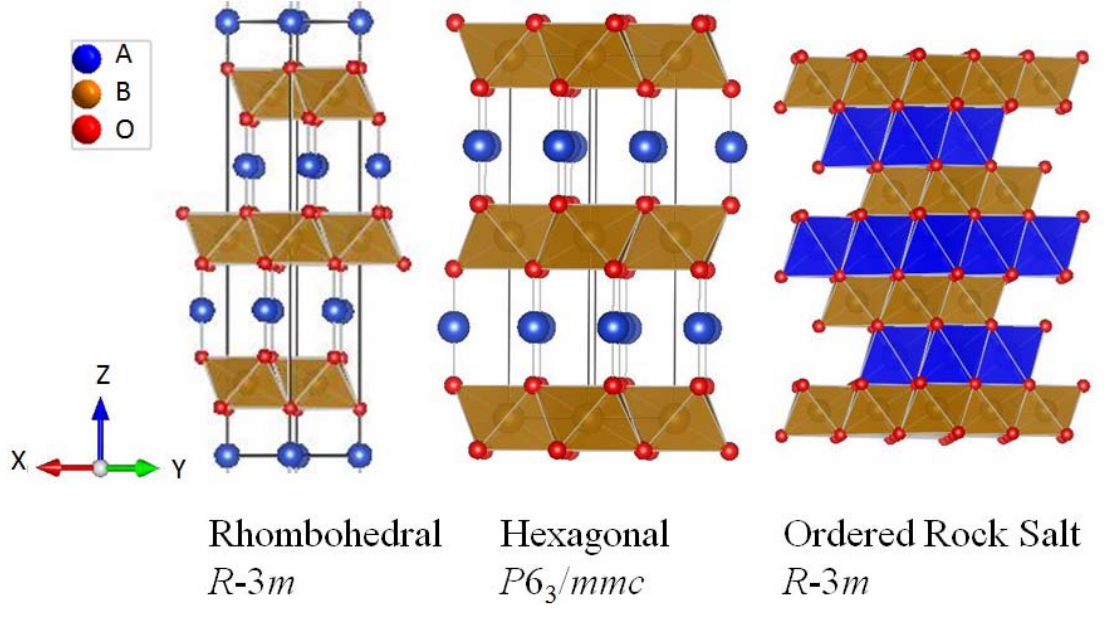
Figure 1. Various crystal structures adopted by AB O 2 layered compounds. Rhombohedral and hexagonal polytypes adopted by delafossites have linear A -O bonding while in ordered rock salt structure, octahedra is formed around both A and B atoms.